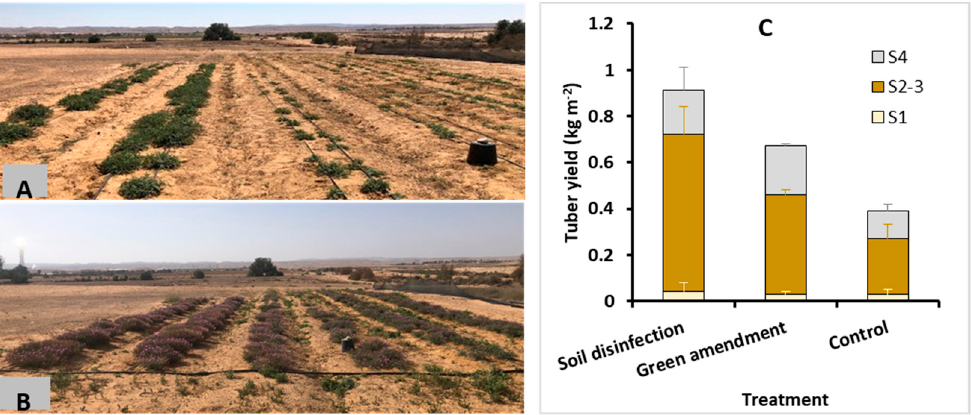
Figure 6. The problem of a consecutive HSB cultivation on the same plot. Regular soil disinfection practices supported normal HSB development ( left ), compared to untreated soil beds ( right ). Two ( A ), and 3 ( B ) months after sowing. Effect of soil disinfection and green amendments on yield of HSB tubers grown in consecutive years ( C ).